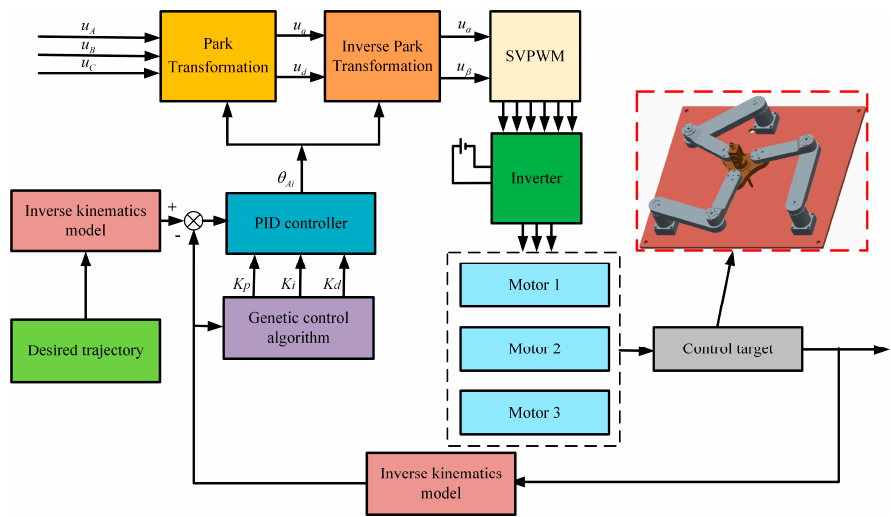
Figure 7. System control block diagram.